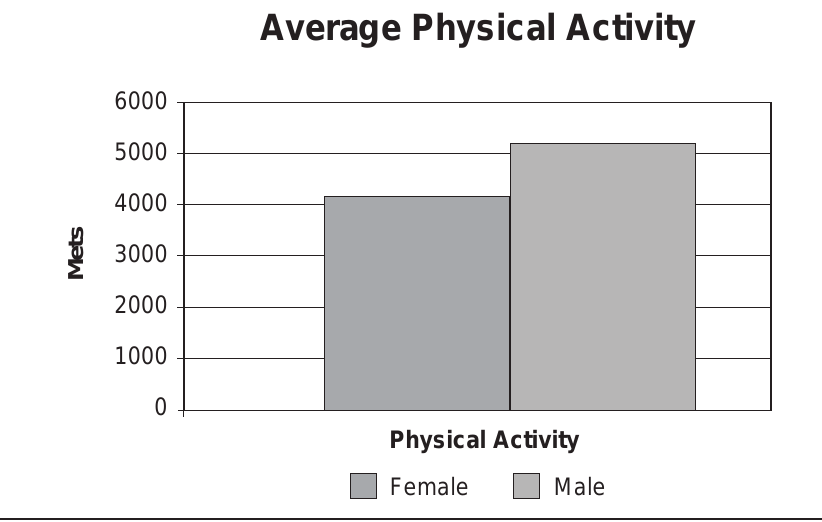
Figure 3: Categories of Physical Activity of males and females.